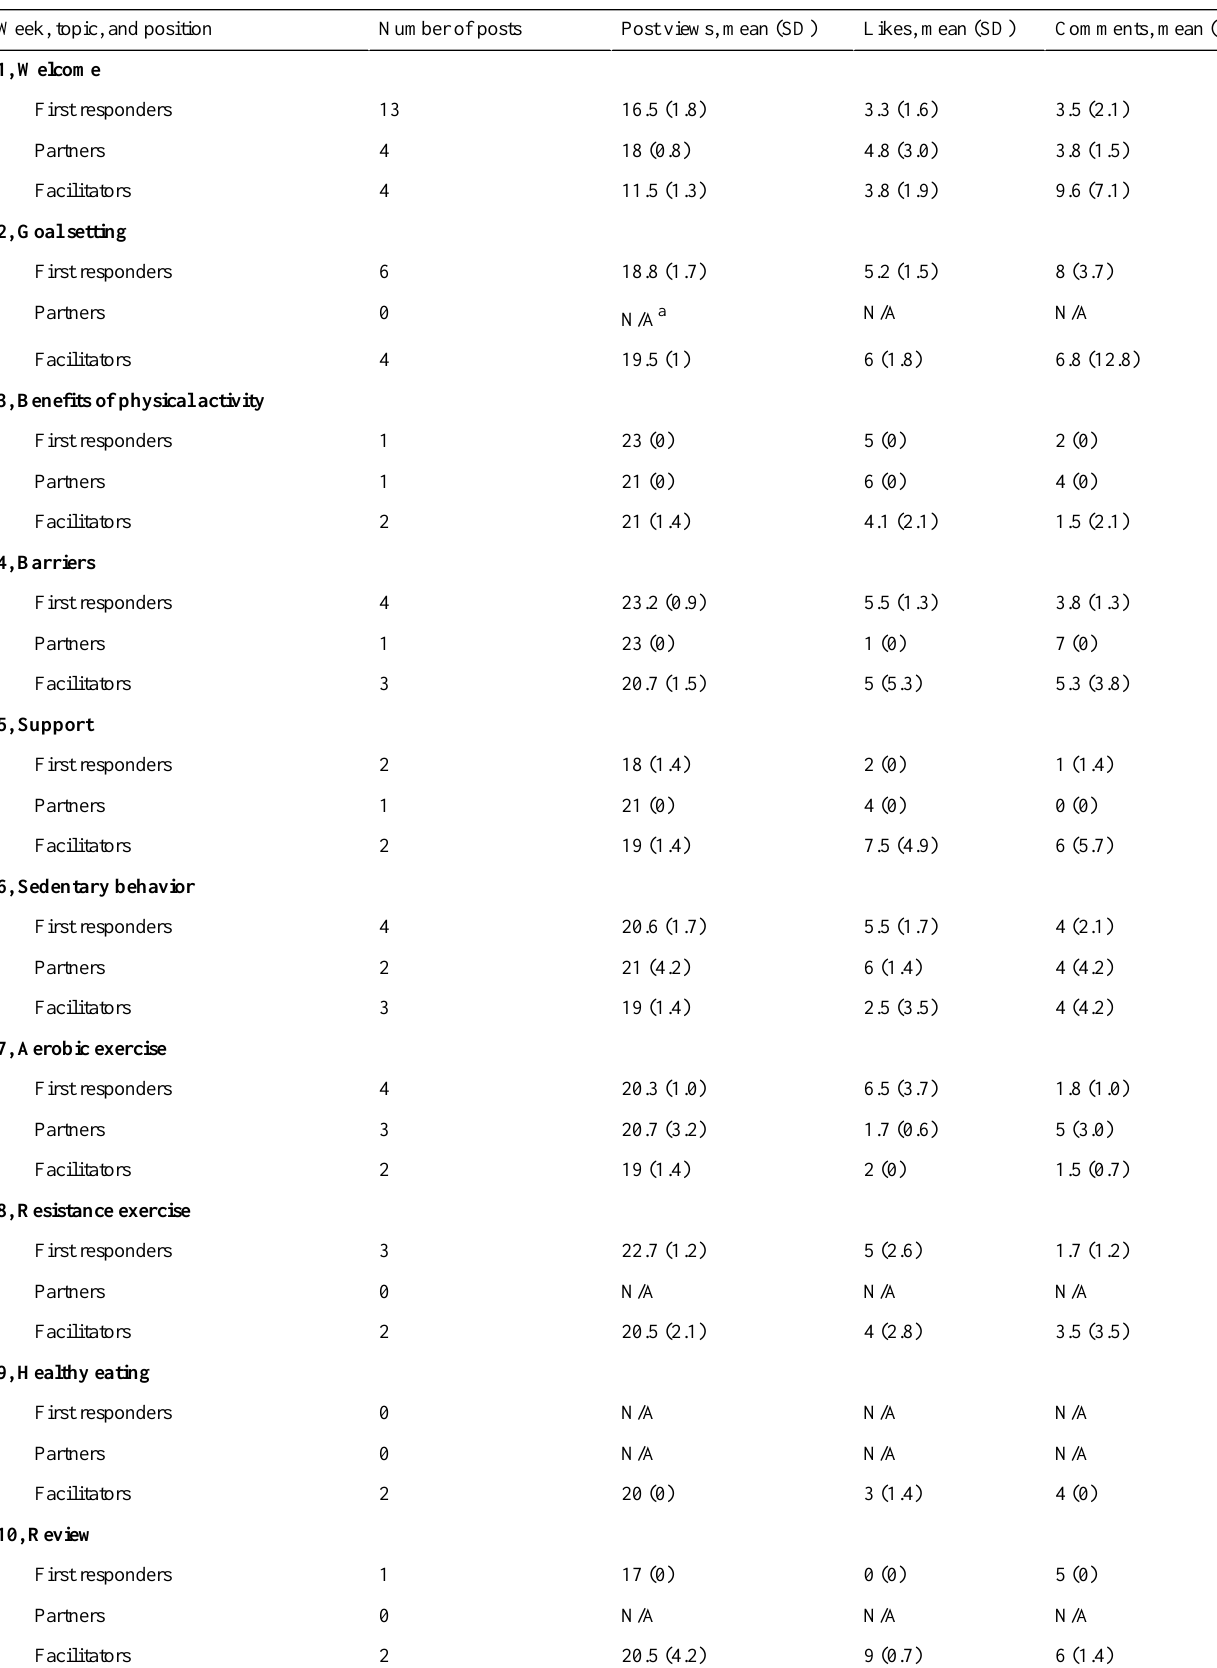
Table 3. Engagement with Facebook posts initiated by first responders, partners, and